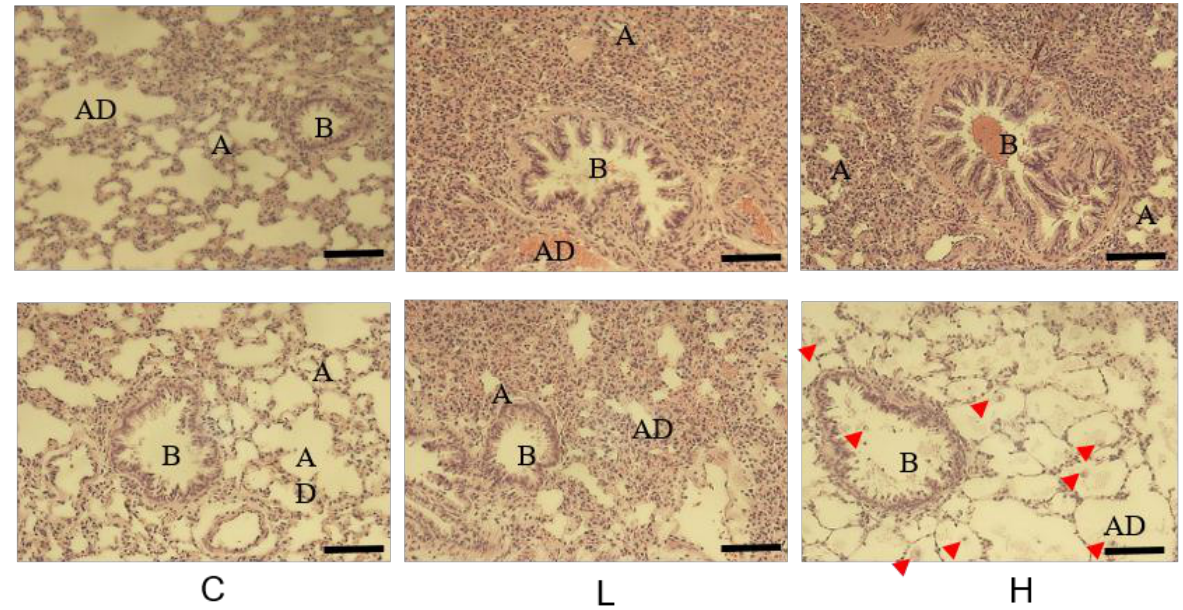
Figure 1. Histological changes in the lungs of rats at 1 day and 4 weeks after instillation of nickel oxide nanoparticles (NiO NPs). Tissues were stained with hematoxylin and eosin. Compared with the control group, the instillation of NiO NPs in rats caused the narrowing of alveolar ducts (AD) and alveoli (A) and blocking of bronchioles (B). In the high-dose group, NiO NPs produced foamy macrophages and exhibited deposition of proteinaceous materials in the alveoli on day 28 after instillation. (Indicator; macrophage, bar = 50 µ m). C: control group; L: low-dose group (50 cm 2 /rat); H: high-dose group (150 cm 2